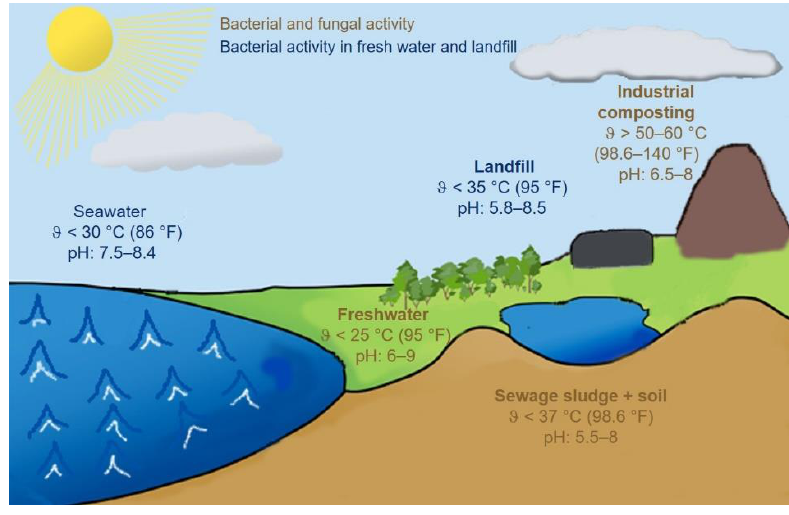
Figure 1. Overview of ambient conditions.